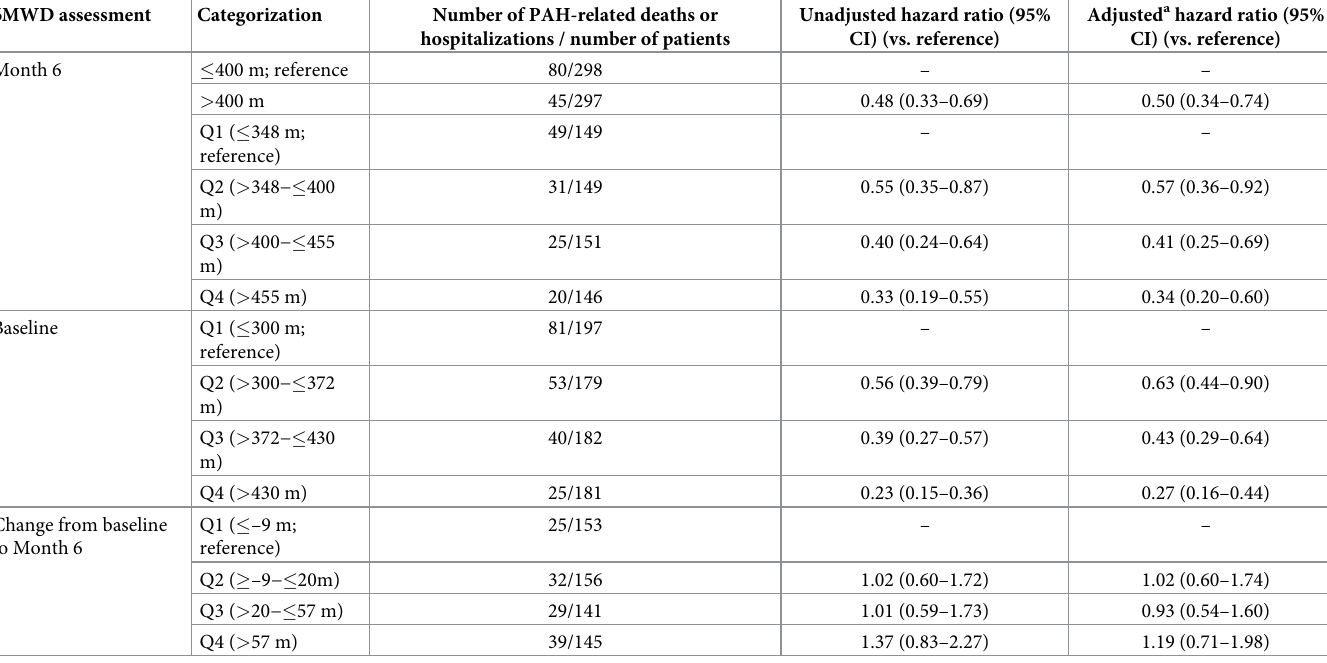
Table 1. Association between 6MWD and time to PAH-related death or hospitalization up to end of treatment.